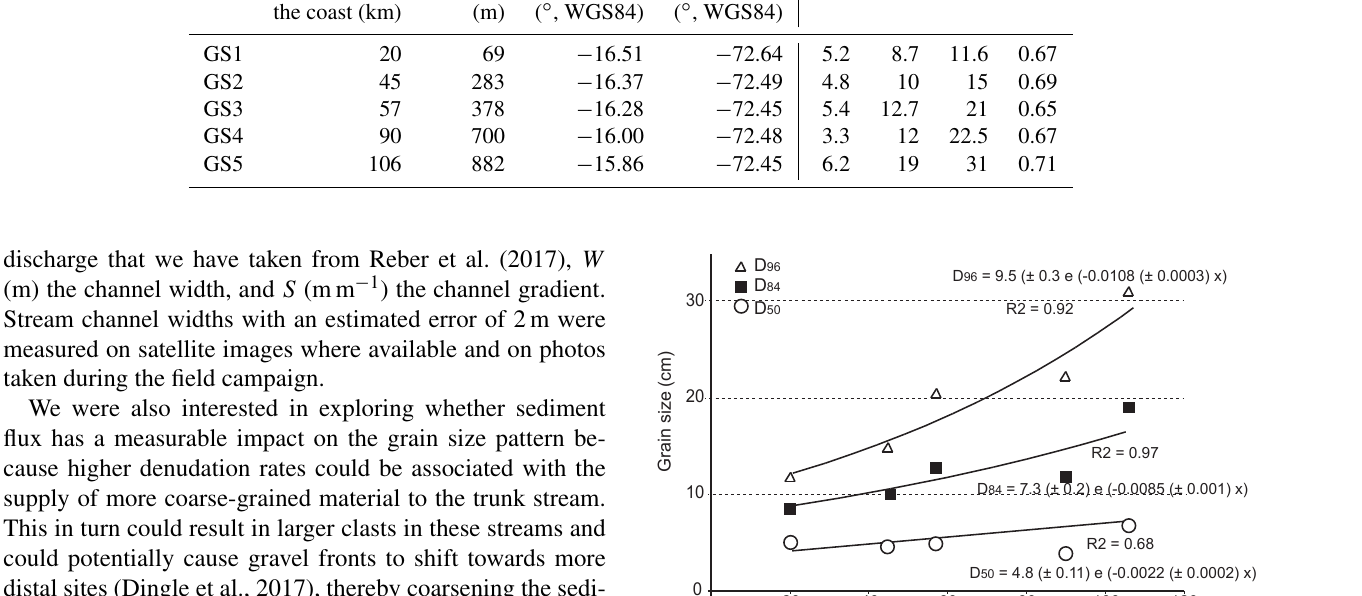
Table 2. Location of the sampling sites in the Majes basin and grain size results in the Majes basin. Distance from Altitude Latitude